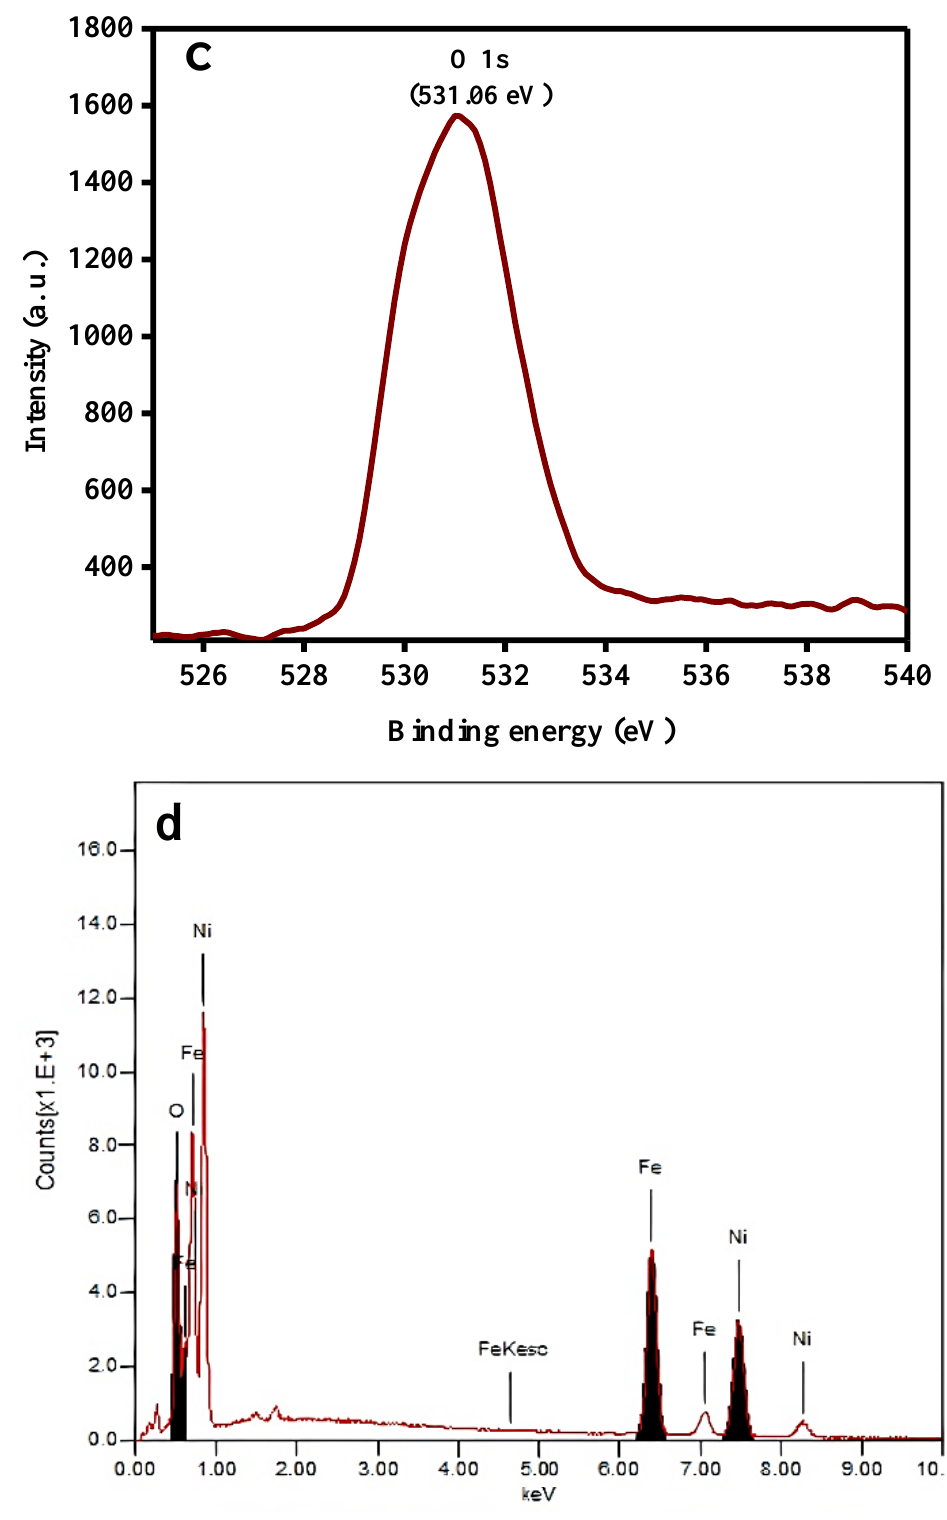
Figure 2. Characterization of FeNi MANPs: ( a ) Fe 2p, ( b ) Ni 2p, and ( c ) O 1s XPS spectra and ( d ) EDS spectrum of FeNi MANPs.